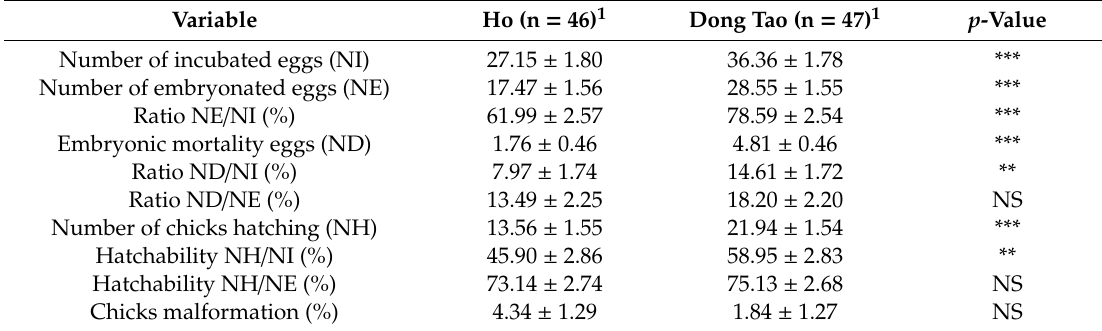
Table 7. Hatching performances of Ho and Dong Tao breed (LSM ± SE).